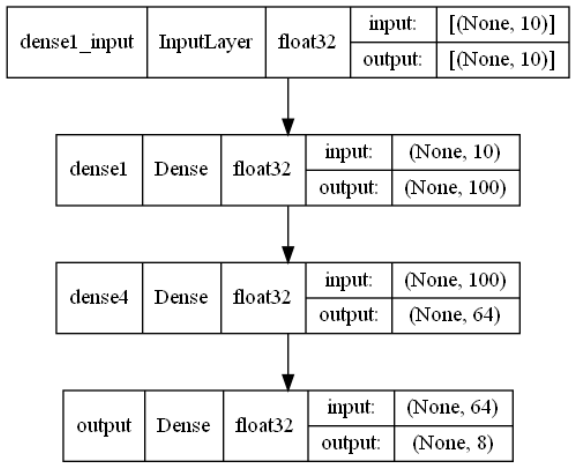
Figure 3. ANN model for six cases.